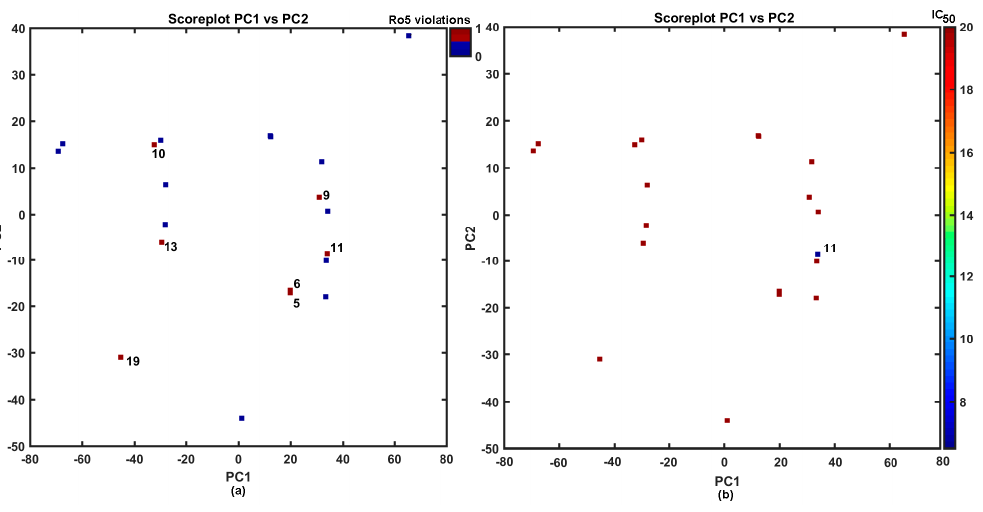
Figure 3. Projection of cinnamic acid anilides 1 – 20 on a plane defined by first vs. second principal components for Dragon descriptors with Ro5 rule violations ( a ) and cytotoxic effect IC 50 ( b ). Colors code numerical values of Ro5 violations and IC 50 .